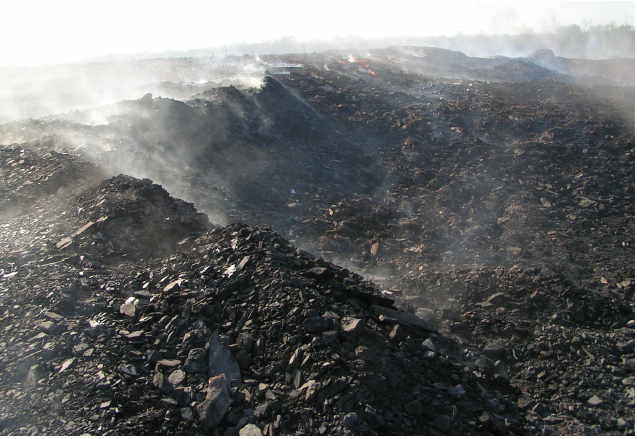
Figure 9. Release of water vapour and fire gases in the dump in Siemianowice Ś l ą skie.